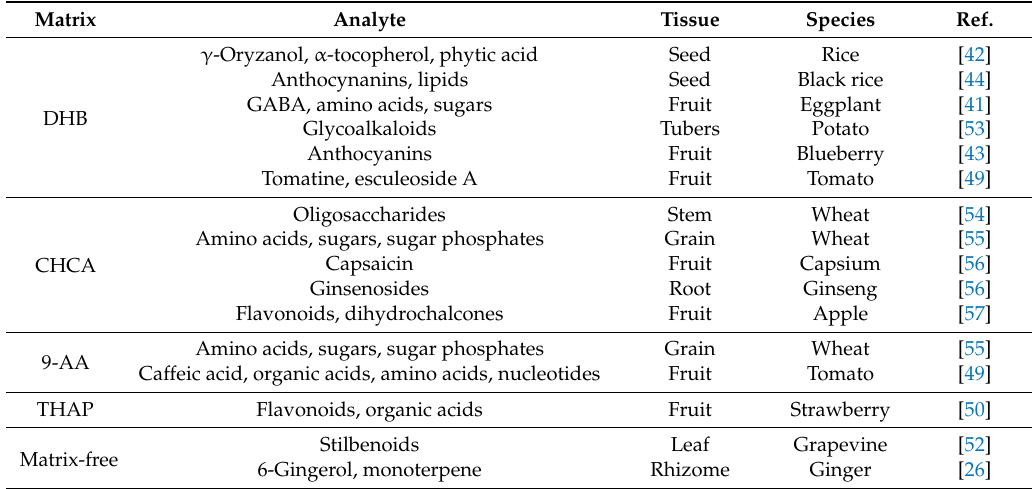
Table 1. Application of laser-based MSI to analysis of phytochemicals in edible